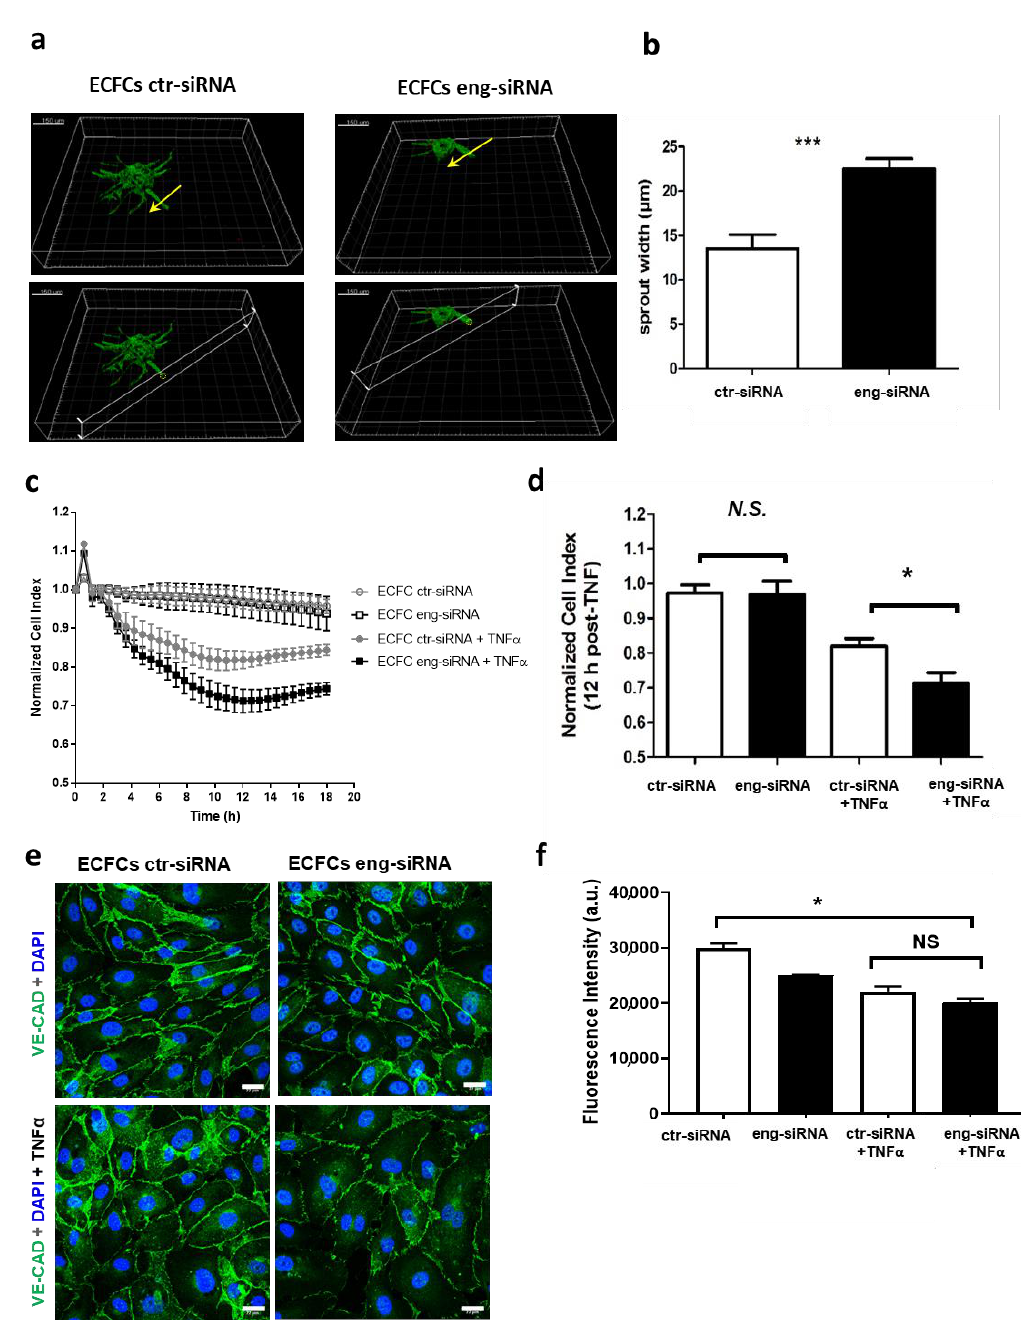
Figure 1. Endoglin silencing affects vessel sprout diameter and permeability. ( a ) Three-dimensional (3D) reconstruction of ECFC ctr-siRNA and ECFC Eng-siRNA to evaluate sprout diameter. In green, Actin F (Alexa 488), and in red, nuclei (TOPRO-3) are stained (scale bar, 150 µm). ( b ) When Eng is suppressed, sprouts are wider than in controls (*** p < 0.001). ( c ) Using a real-time impedance-based cell analyzer (iCELLigence system, ACEA Biosciences, San Diego, USA), ECFC ctr-siRNA and ECFC Eng-siRNA are analyzed in basal condition and under 20 ng/mL TNF α stimulation (gray and black lines, respectively). As shown by the quantification in ( d ), a significant difference between ECFC ctr-siRNA (white column) and ECFC Eng-siRNA (black column) is found 12 h after TNF α stimulation (* p < 0.05). ( e ) Immunofluorescence staining for VE-CAD in ECFC-ctr and ECFC Eng-siRNA with the absence of or in the presence of 20 ng/mL TNF α for 1 h (scale bar, 22 µm). ( f ) Quantification of the pictures in ( c ) does not show differences between control and Eng-siRNA in terms of VE-CAD membrane staining nor of fluorescence intensity in the presence of TNF α (* p < 0.05).